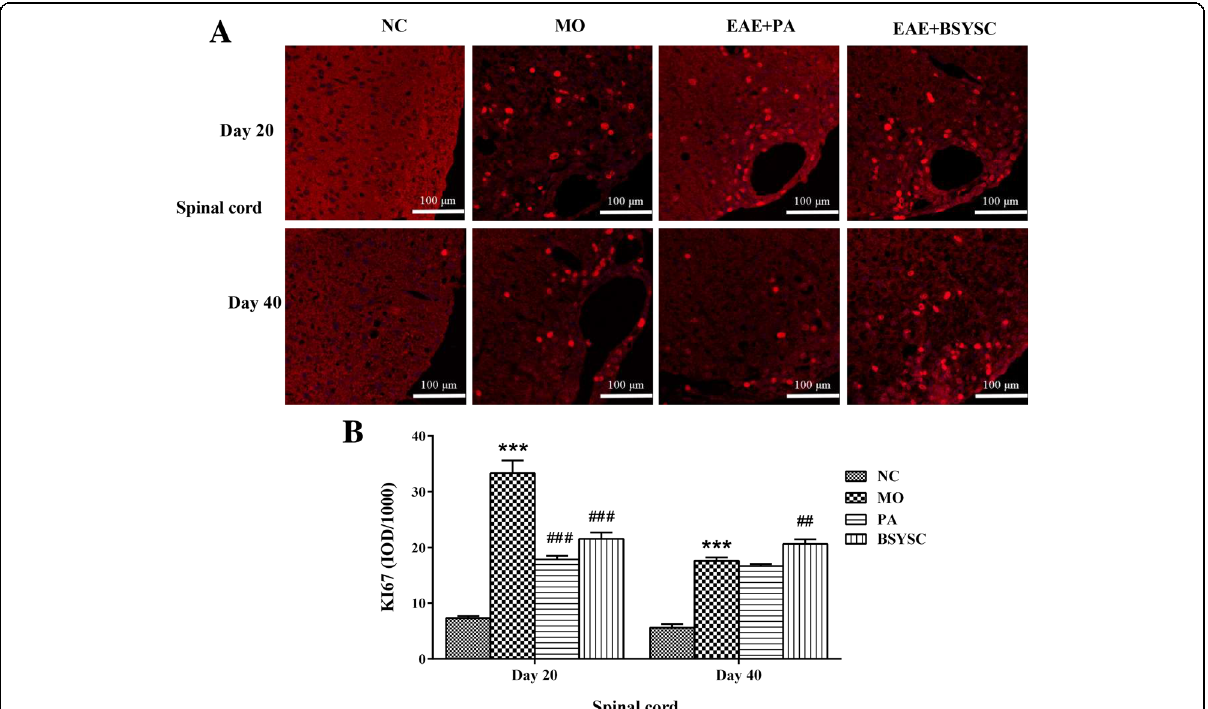
Fig. 4 KI67 protein expression in the spinal cord of mice treated with or without BSYSC 20 and 40 dpi. BSYSC significantly decreased KI67 expression 20 dpi, but increased KI67 40 dpi. a The representative immunofluorescent staining of KI67 was shown in each group, magnification (×40). b Semi-quantification of integrated optical density (IOD) on KI67 expression was exhibited. Data are expressed as means ± SE, n = 5 for each group. *** p < 0.001 vs. NC; ## p < 0.01, ### p < 0.001 vs.